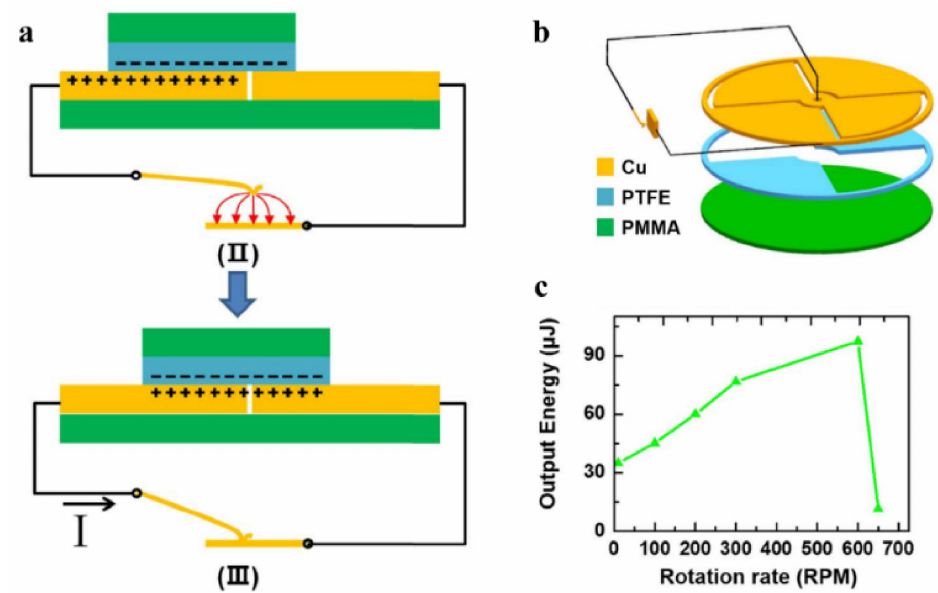
Figure 7. Power management with electrostatic switch. ( a ) Motion of cantilever vibration switch under electrostatic attraction. ( b ) Turntable TENG with the electrostatic switch. ( c ) The dependence of output energy on rotation rate. Reproduced with permission [73]. Copyright 2018,